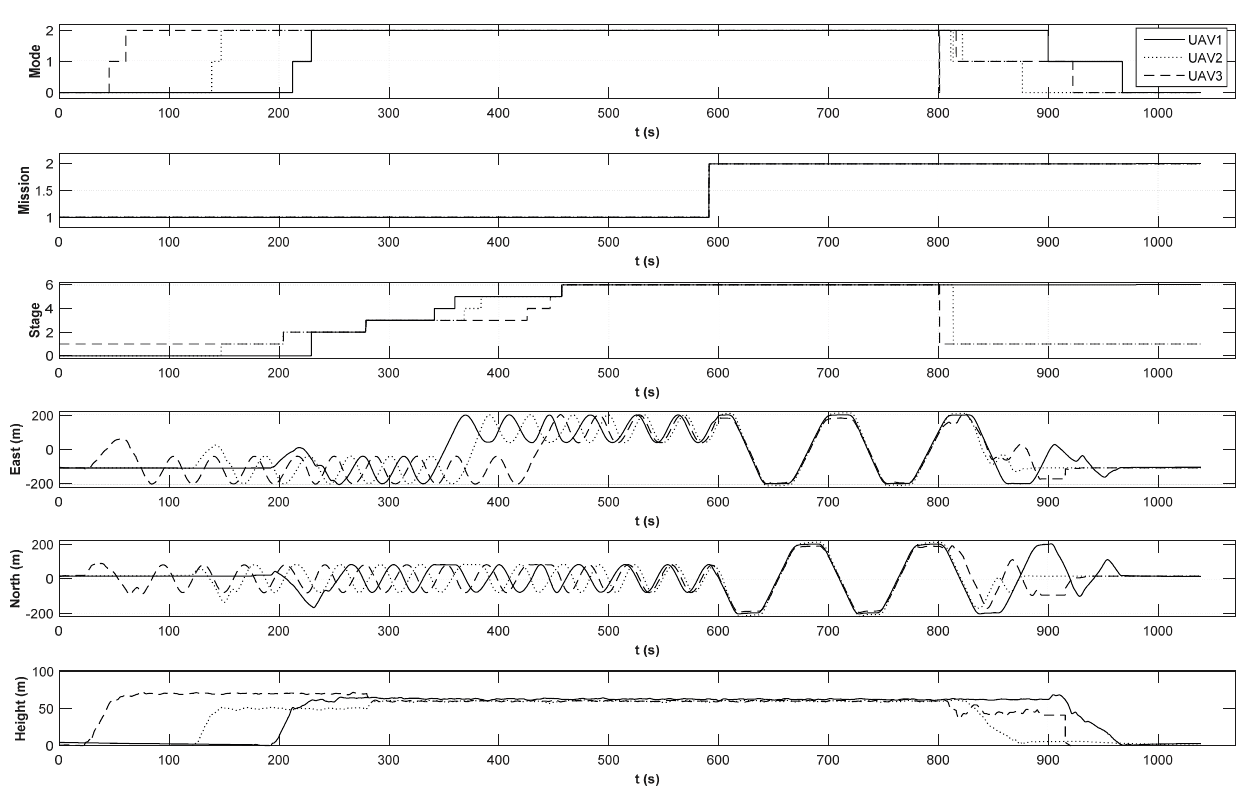
Figure 16. Position histories of integrated formation